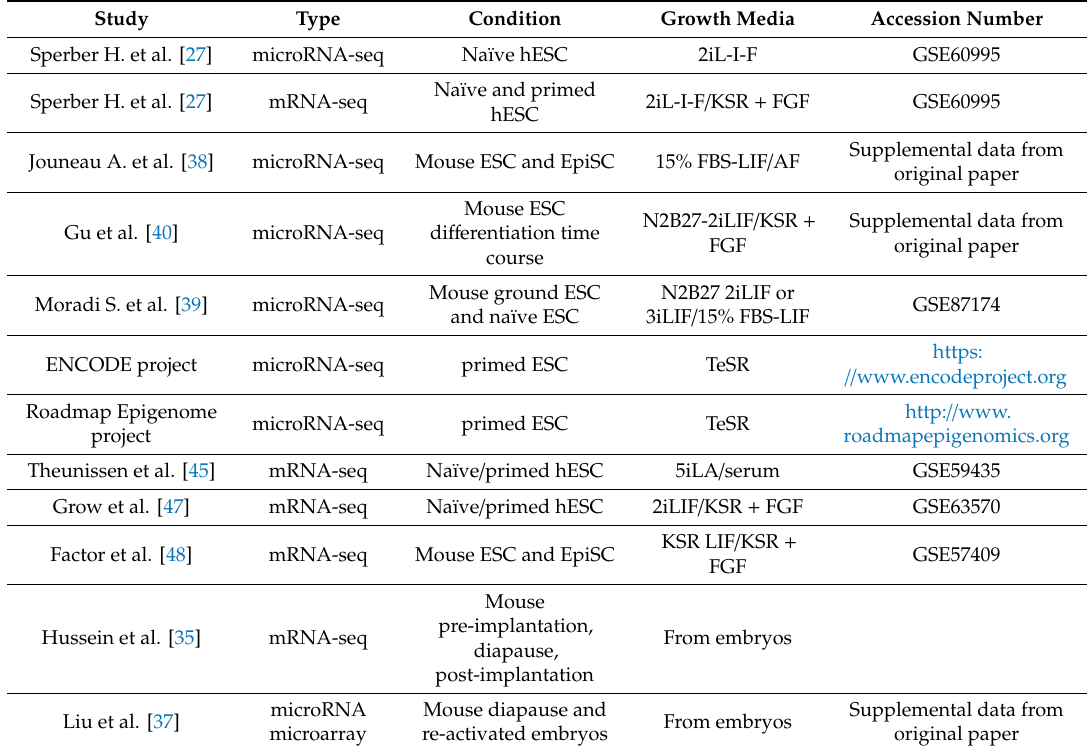
Table 1. Datasets used in this